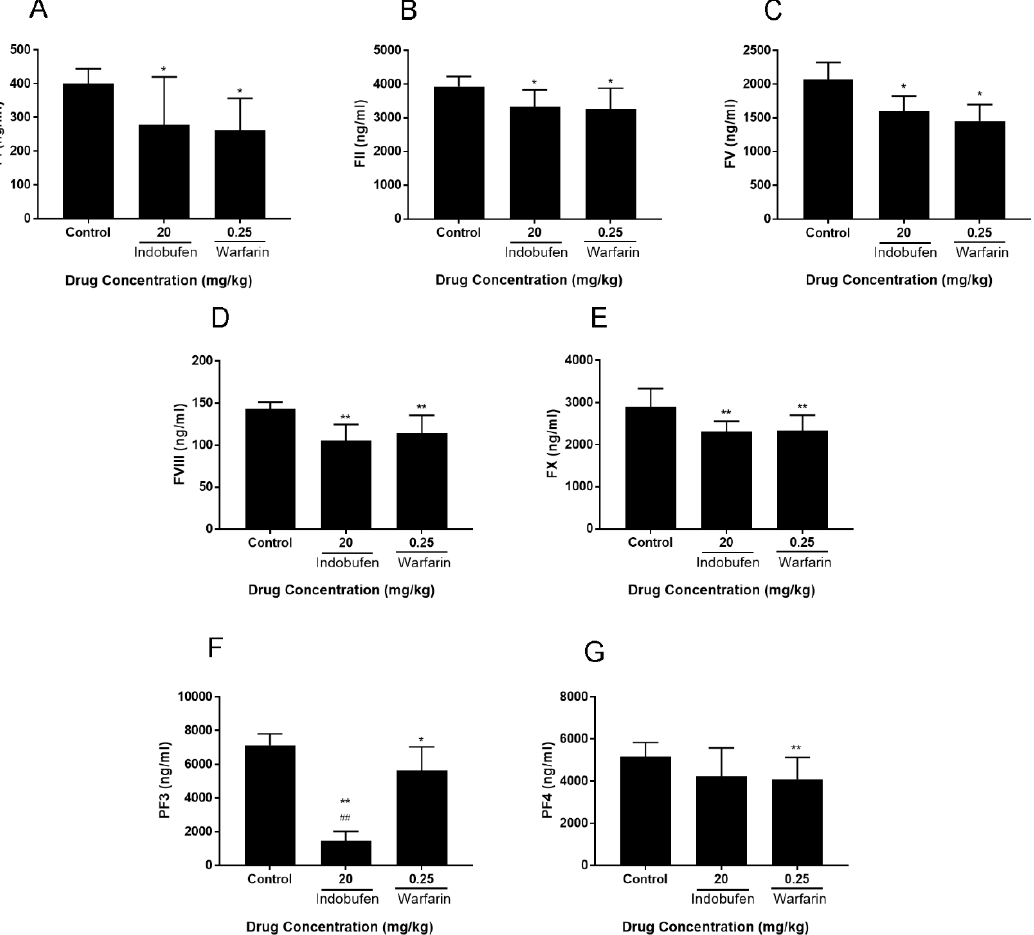
Figure 4. The effects of indobufen on coagulation factor 1 (FI, A ), 2 (FII, B ), 5 (FV, C ),8 (FVIII, D ),10 (FX, E ), and platelet factor 3 (PF3, F ), 4 (PF4, G ) in the poor platelet plasma (PPP) of rabbits. * p < 0.05, ** p < 0.01 versus the control group; ## p < 0.01 versus warfarin sodium group (mean ± S.D., n = 9).